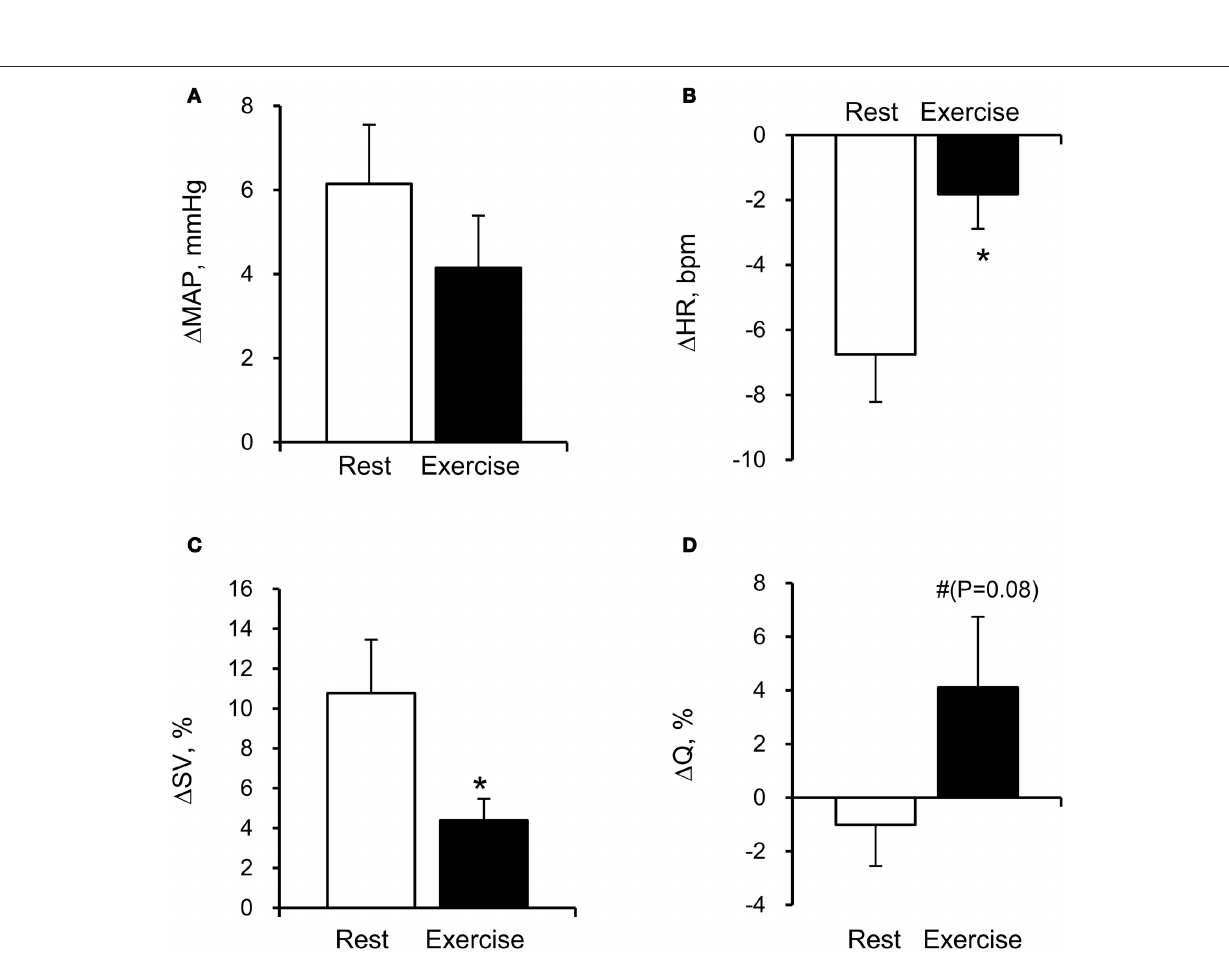
Frontiers in Physiology | Exercise